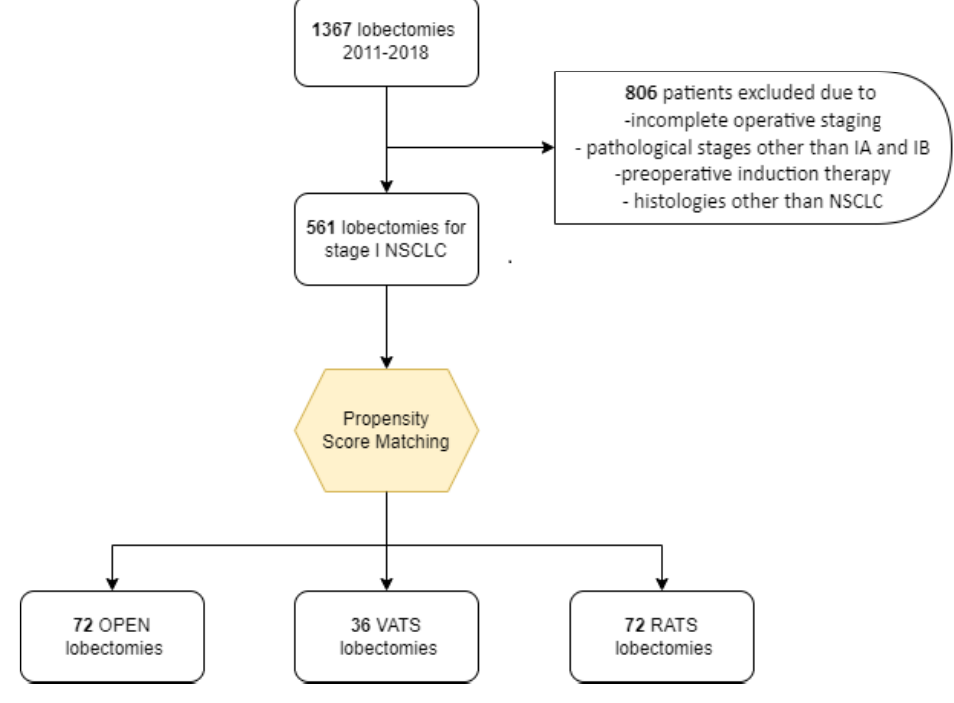
Figure 1. Patients’ selection algorithm.